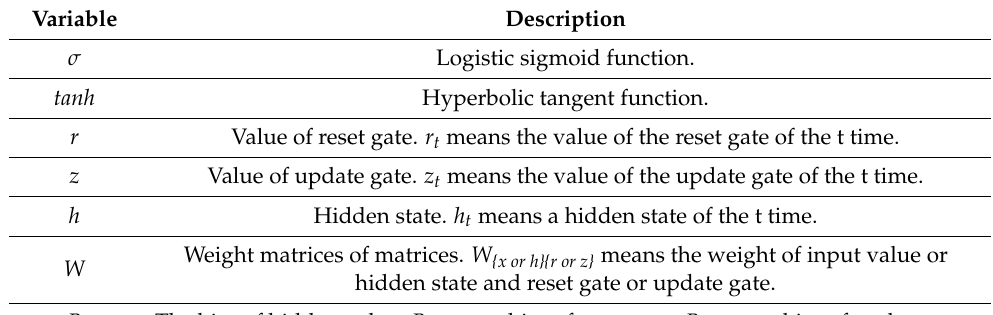
Table 6. Variables of the GRU